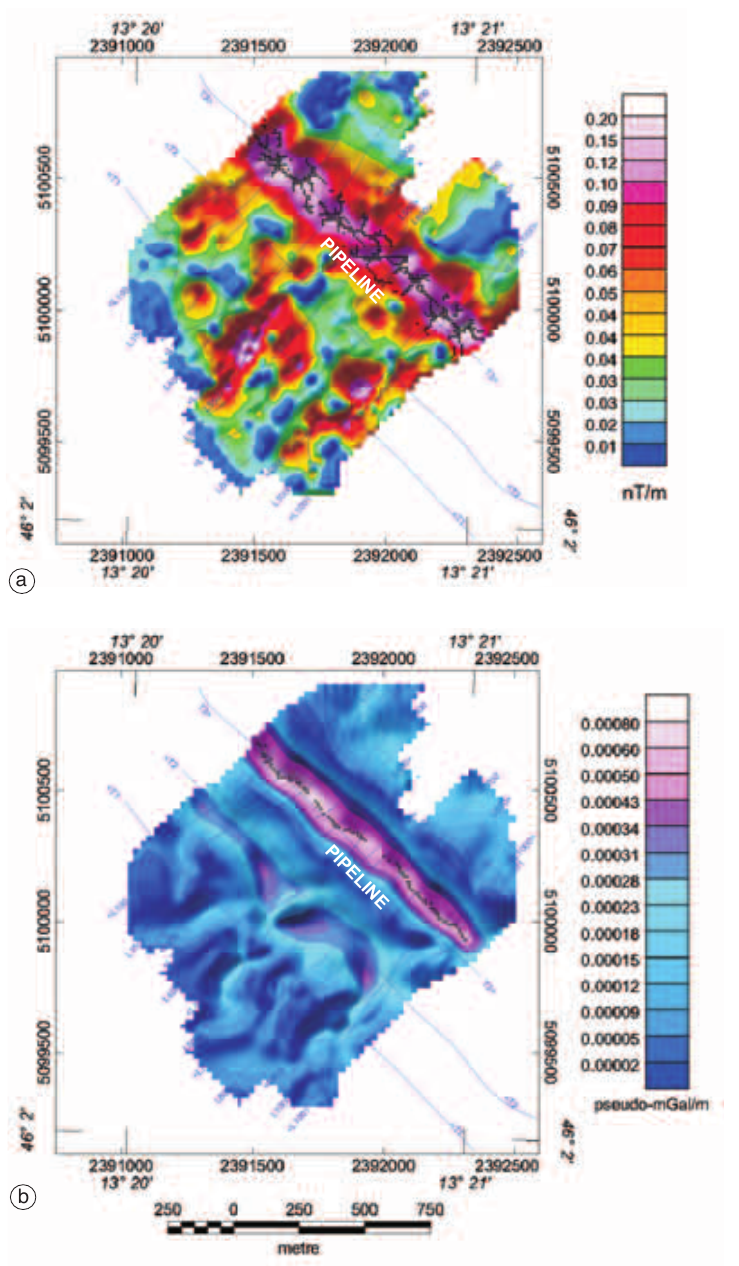
Fig. 2a,b. a) Three-dimensional analytic signal map in the pipeline area. Local peaks over the buried pipeline are displayed as black triangles. b) Maximum horizontal gradient of pseudo gravity with local peaks indicated with black